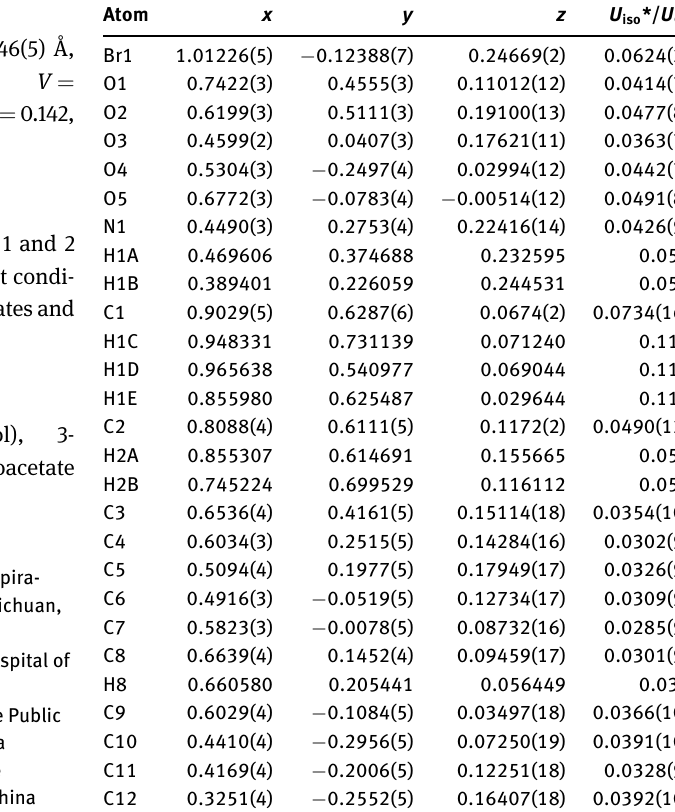
Table 2: Fractional atomic coordinates and isotropic or equivalent isotropic displacement parameters (Å 2